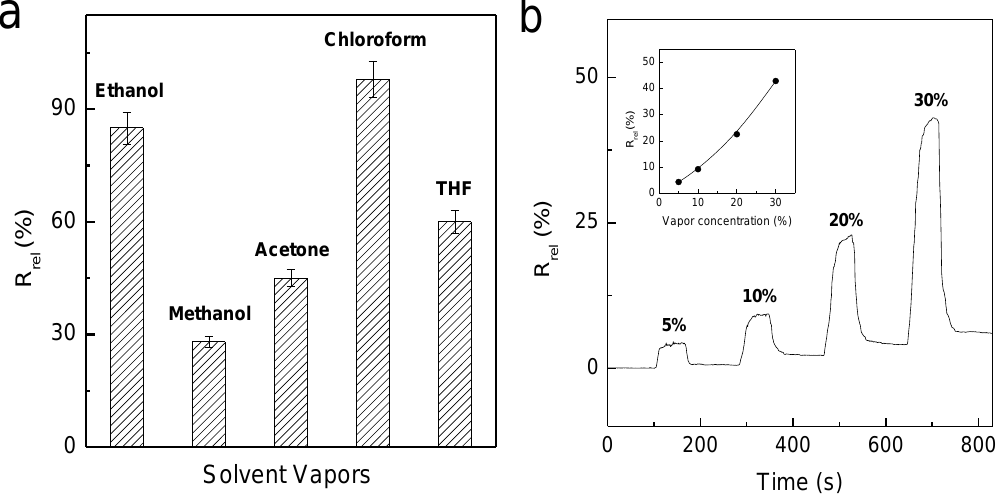
Figure 5. ( a ) The resistance response (R rel ) of the MWCNT-coated cellulose fibers after exposure to various solvent vapors (saturated vapor concentration at 25 °C, Table S1) for 60 s; ( b ) the resistance response (R rel ) of the MWCNT-coated cellulose fiber upon sequential exposure to various acetone vapor concentrations (the inset presents the exponential relationship between acetone vapor concentration and R rel